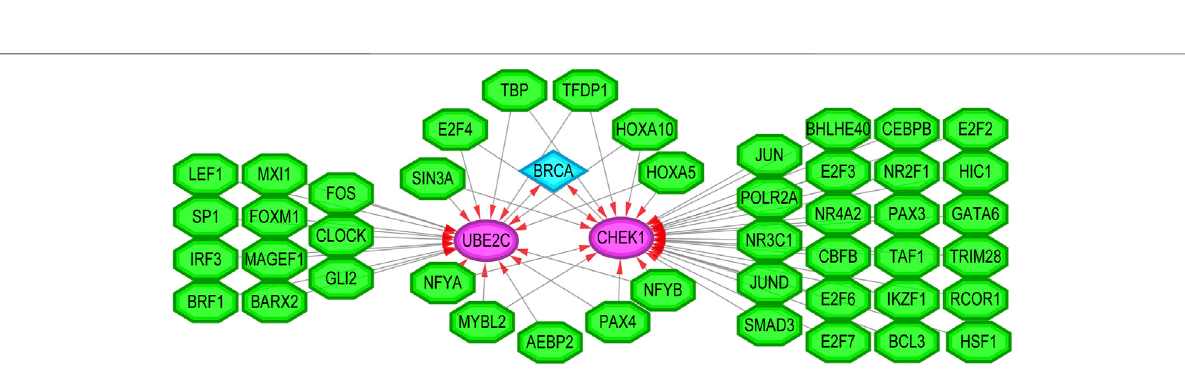
Frontiers in Genetics |